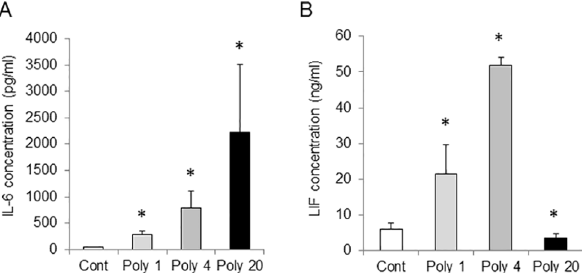
Fig 3. Changes in interleukin-6 (IL-6) and leukemia inhibitory factor (LIF) concentrations in the maternal serum in response to maternal immune activation (MIA). (A) Concentration of IL-6 in maternal serum (MS). (B) Concentration of LIF in MS. MIA was induced by an intraperitoneal (i.p.) injection of 1, 4 or 20 mg/kg polyriboinosinic-polyribocytidylic acid [poly (I:C)] at 12.5 days post-coitum (dpc), maternal serum was analysed 3 h after the injection. Controls were injected with an equal volume of saline (0.01 ml/g body weight). Injection of polyriboinosinic-polyribocytidylic acid [poly (I:C)] at 12.5 dpc induced IL-6 in MS in a dose dependent manner. In contrast, the concentration of LIF in MS was increased by the injection of poly (I:C) at 1 and 4 mg/kg; the concentration of LIF in MS was decreased to the control level by the injection of poly (I:C) at 20 mg/kg. Cont: control, Poly 4: poly (I:C) 4 mg/kg, Poly 20: poly (I:C) 20 mg/kg. * , p < 0.05. Number of dams = 3 or 4 in each group. Error bars , SEM.